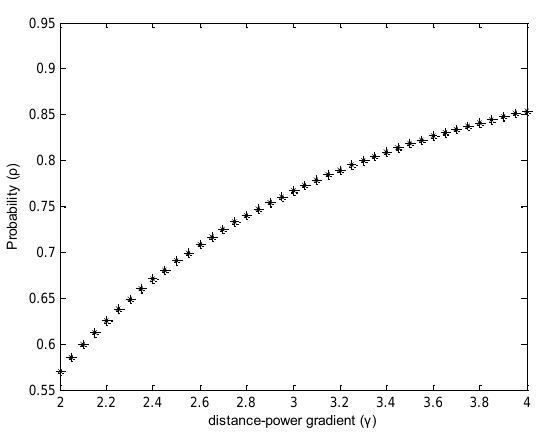
Figure 5. The relationship between γ and ρ .